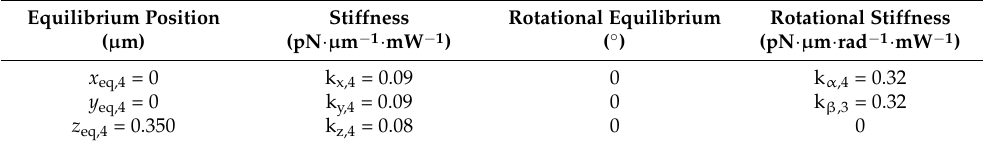
Table 3. Values of trap stiffnesses, rotational equilibrium and rotational trap stiffness for an RBC trapped by a four-beams optical tweezers. The stiffnesses are normalized over the total power. Equilibrium Position ( µ